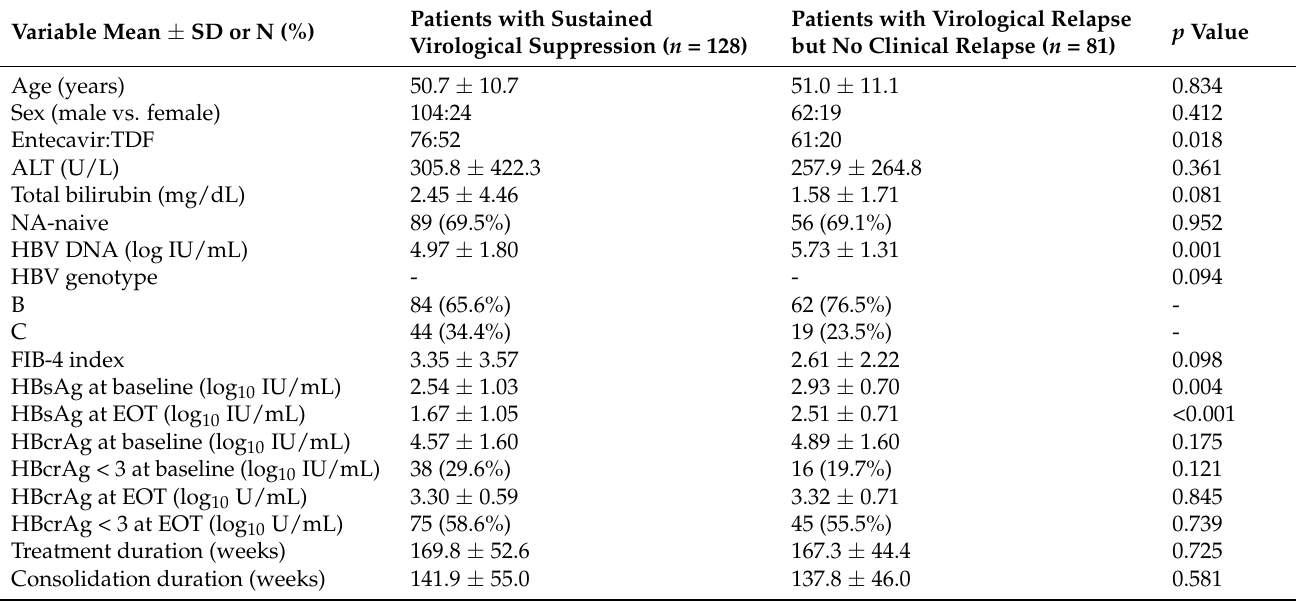
Table 1. Clinical features of the study population.